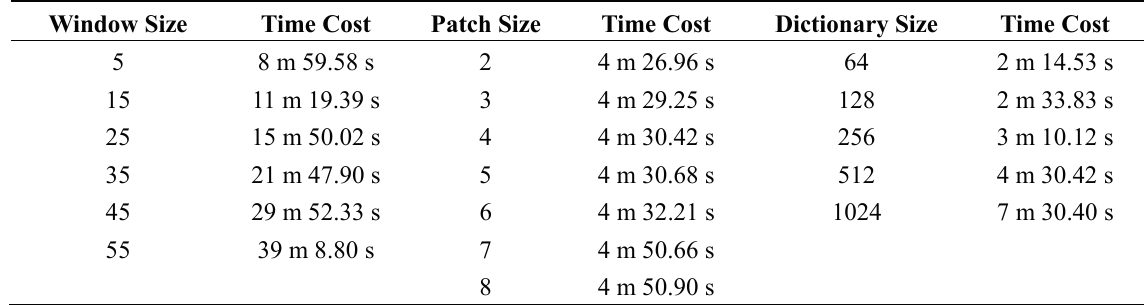
Table 6. Changes in the computation cost as the model parameters